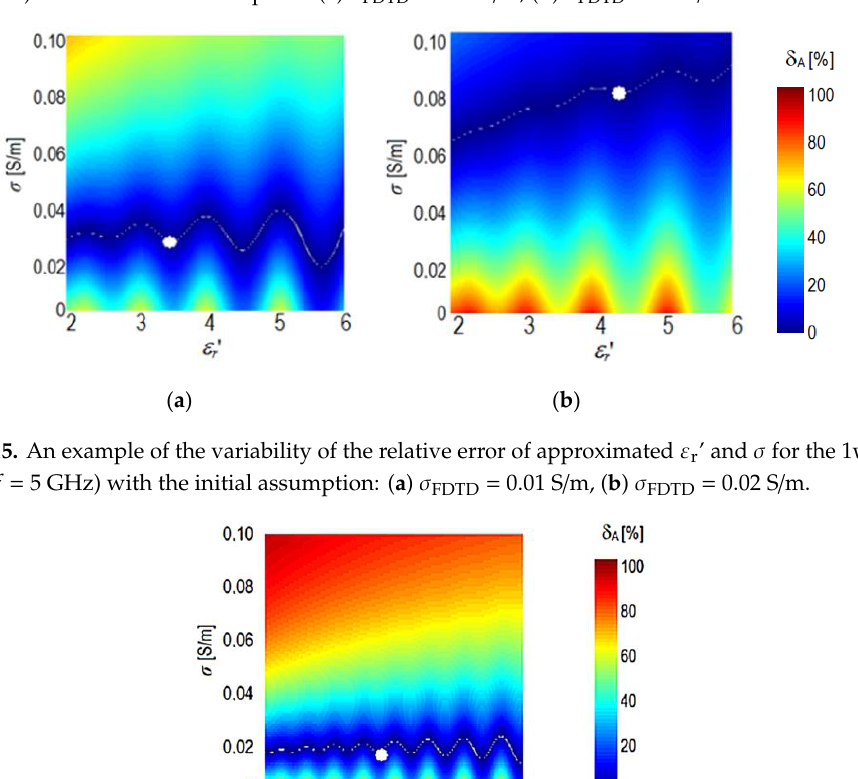
Figure 14. An example map of the relative error of approximated ε r ’ and σ for the 1w_B18 model ( f = 5 GHz) with the initial assumption: ( a ) σ FDTD = 0.04 S / m, ( b ) σ FDTD = 0.1 S / m.